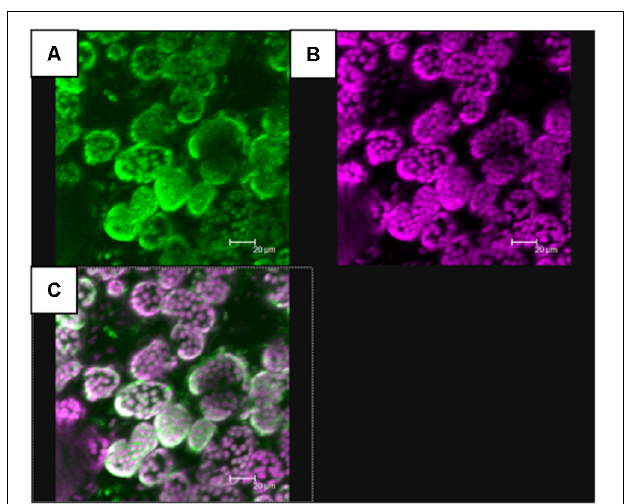
FIGURE 5 | In vivo localisation of PhGES by transient transformation of N. benthamiana with Agrobacterium tumefaciens carrying a pMDC32 expression vector where PhGES coding sequence, was fused with the GFP coding sequence. PhGES was localised in chloroplasts. Two independent experiments were performed and chloroplastic localisation was found at least in several plants in both assays. Picture shows the green fluorescence of GFP (A) , auto fluorescence of chlorophyll in purple (B) , and their co-localisation (C)